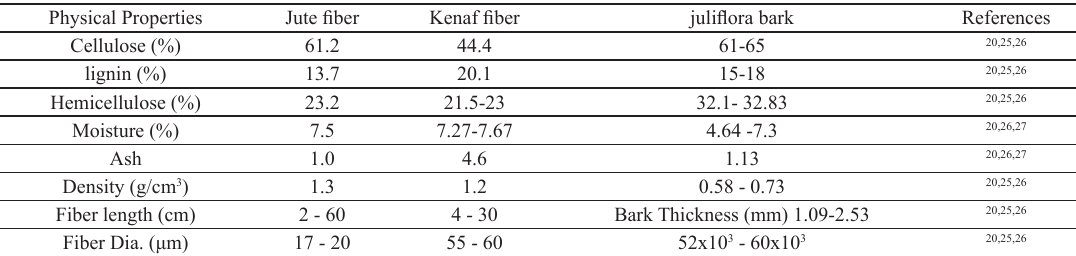
Table 1. Chemical constituents and Physical properties of Natural Fibers. Physical